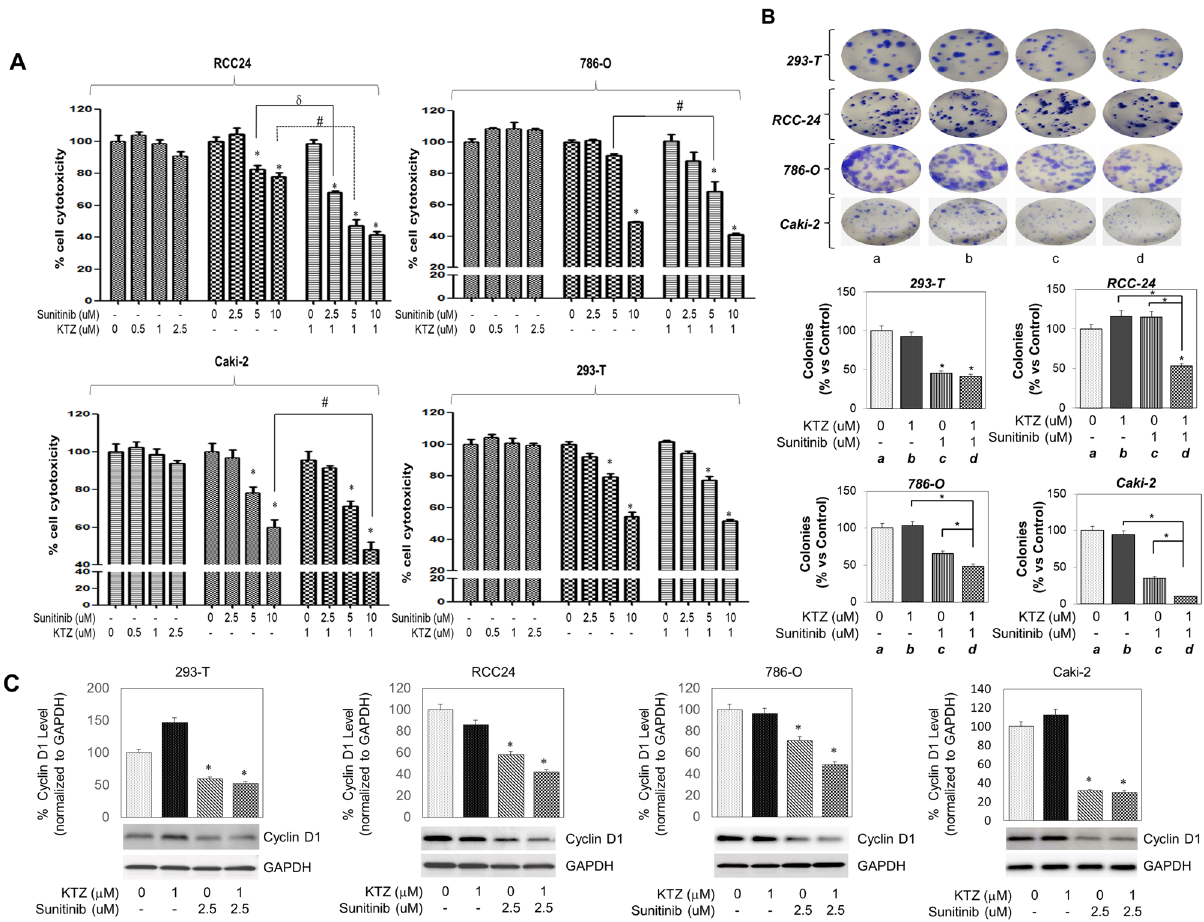
Figure 4. Antiproliferative effects of the two-drug combination are better than those of the single-drug combination in the RCC-24, 786-O and Caki-2 cell lines. ( A ) Combination effect of Ketoconazole and sunitinib on cell proliferation determined by using the MTT assay. Cells were treated with the indicated concentrations of Ketoconazole and sunitinib, and proliferation was determined 48 h later. ( B ) Clonogenic assay was performed in the 293-T, RCC-24, 786-O and Caki-2 cell lines. Colonies were counted 14 days later. Data are presented as the means ± SD from three independent experiments and shown in bar graphs (*p < 0.05 vs. K − K + S or S − K + S). ( C ) Note a significant decrease in cyclin D1 levels after sunitinib treatment and its enhancement in combination treatment with ketoconazole. The densitometric plots shows fold decrease in the expression of signaling molecule. GAPDH immunoblot used as loading control. Full blots are presented in Supplementary Fig.